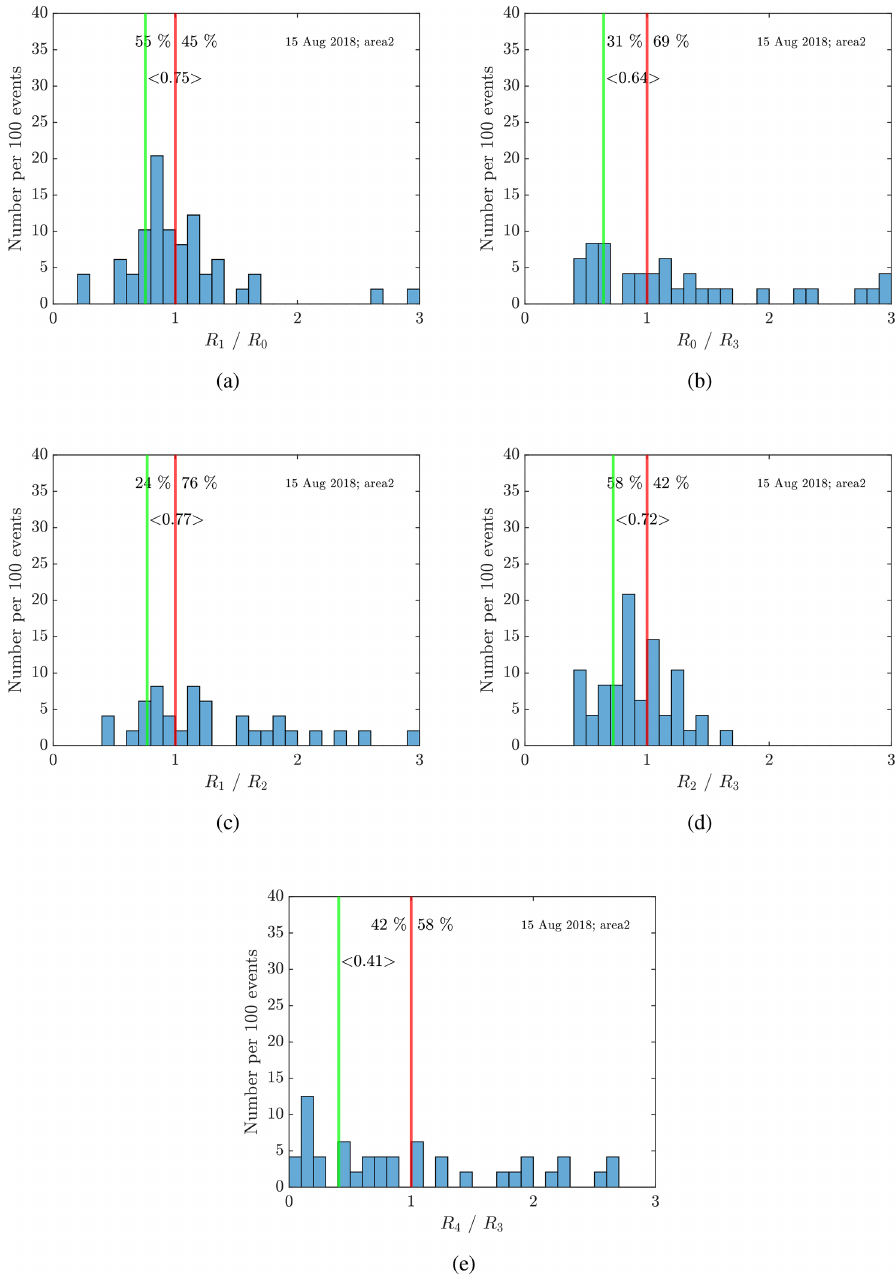
Figure 12. Average of (a) decline, (b) overshoot, (c) heating, (d) recovery, (e) relaxation for the observed data on 15 August 2018 in area 2. Only overshoot curves with a minimal background amplitude of R 0 > 10 10 . 5 are considered. The ratios are chosen so that if we observe an overshoot curve like shown in Fig. 1, all ratios are smaller than 1. Thus, the histograms are clipped at a maximum ratio of 3. The green line and the corresponding number display the mean for all ratios smaller than